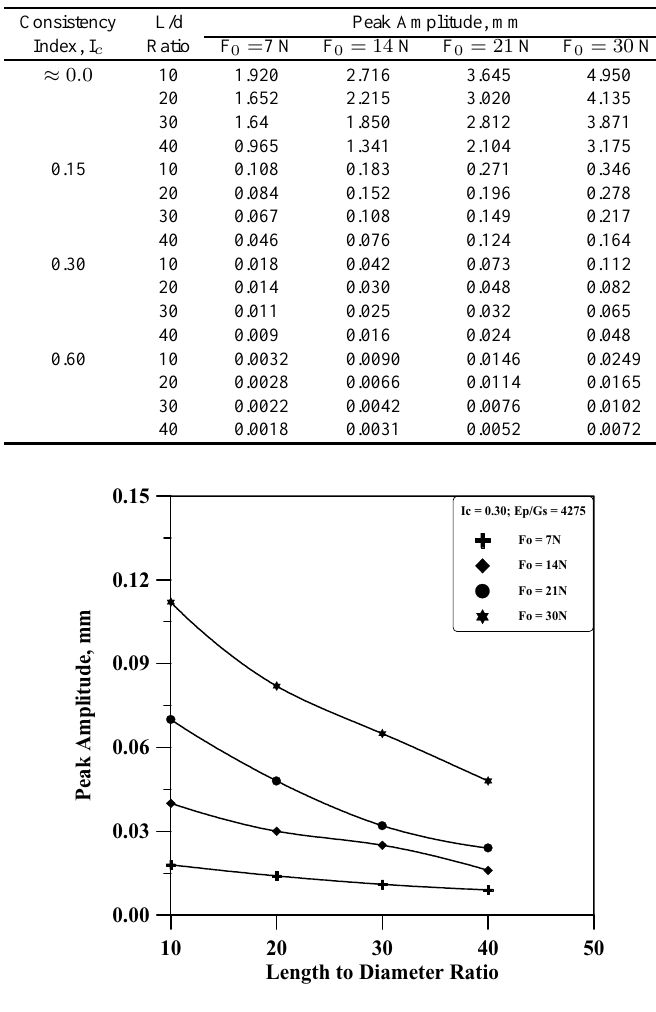
Fig. 11. Variation of peak amplitude with pile